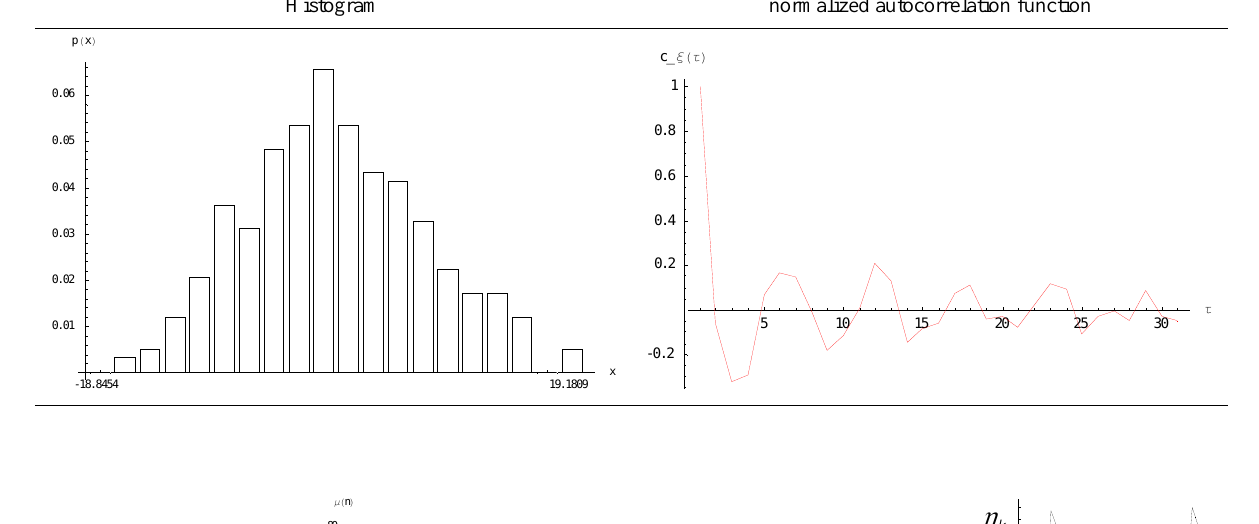
Table 1. Histogram and normalized acf of residuals ξ ( t ) which shows Gaussian colored noise properties. Histogram normalized autocorrelation function